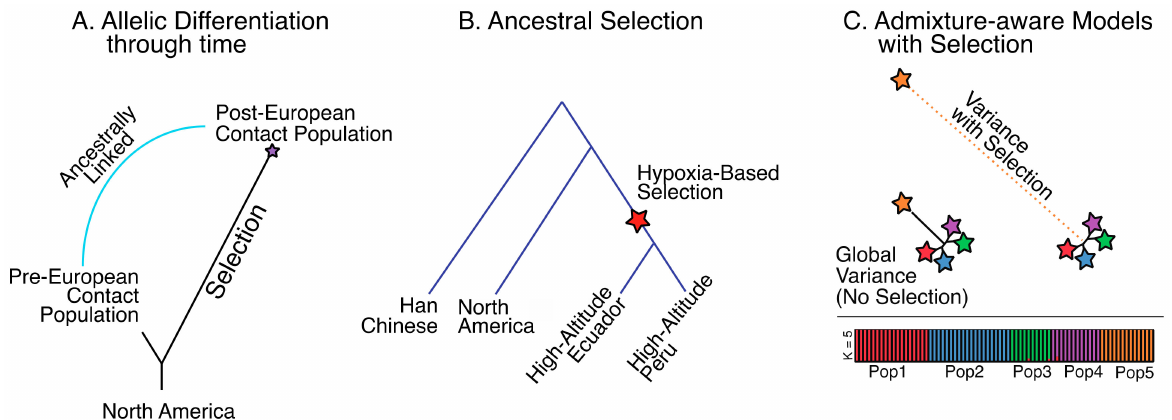
Figure 4. Various schemes for detecting selection in South American living and ancient populations. ( A ) Detecting allelic differentiation through time in a single population. ( B ) Detecting ancestral selection leading to adaptive phenotypes in two populations; ( C ) Detecting selection with admixture aware